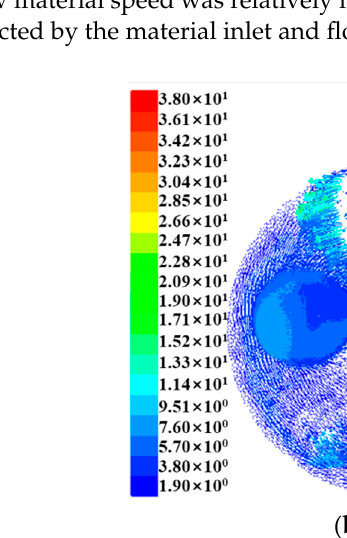
Figure 14. The velocity vector diagram of the crushed straw material phase of different cross-sections along the Y-axis in the impeller volute area. ( a ) Y = − 92 mm (Back wall of volute). ( b ) Y = 92 mm (Front wall of